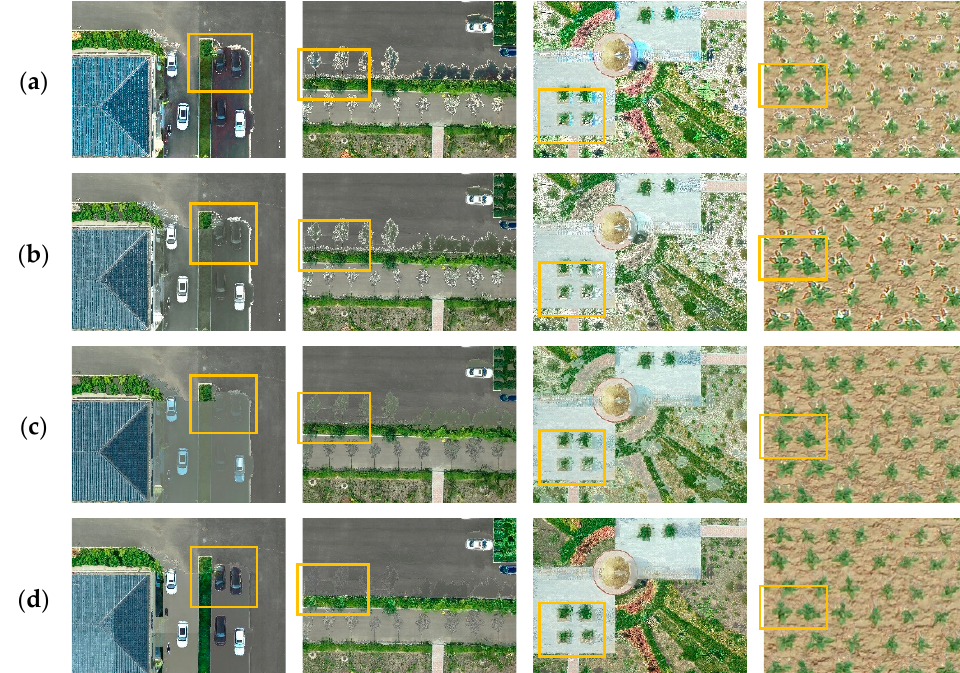
Figure 7. The compensation results of different methods applied to the four study cases: ( a ) illumination correction; ( b ) color transfer; ( c ) shadow synthesis; ( d ) the proposed method. The orange boxes are the region that needs to be locally enlarged.